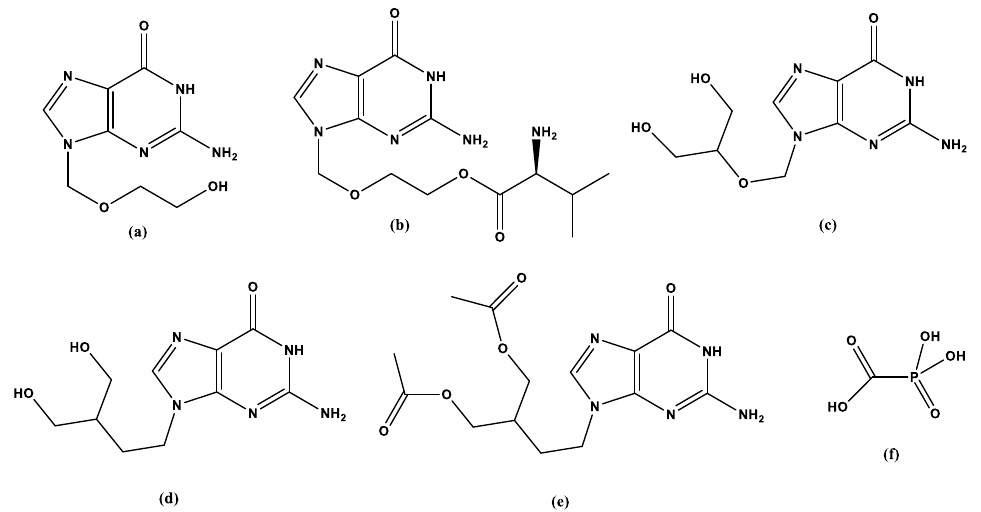
Figure 1. Antiherpetic drugs used in the clinic: ( a ) acyclovir, ( b ) valacyclovir, ( c ) ganciclovir, ( d ) penciclovir, ( e ) famciclovir, ( f ) foscarnet.